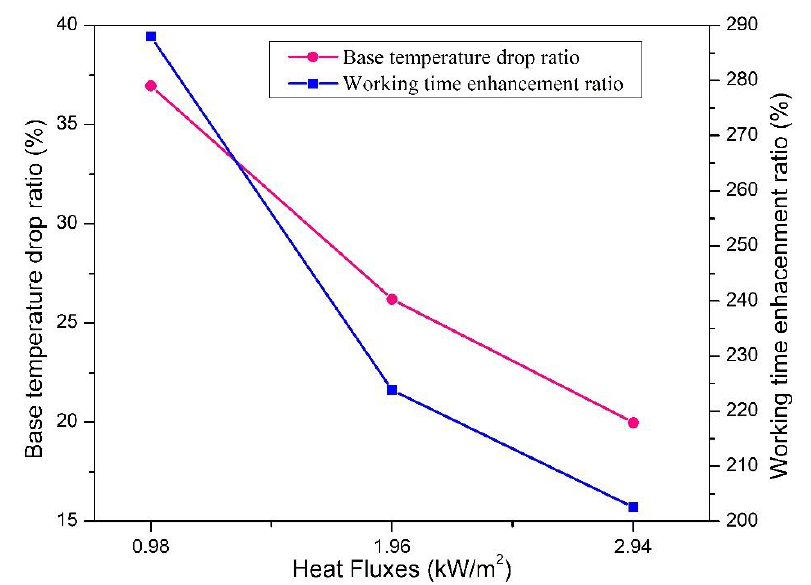
Figure 11. Comparison of baseline temperature reduction ratio and operating time enhancement ratio of Cu foam heat sink.